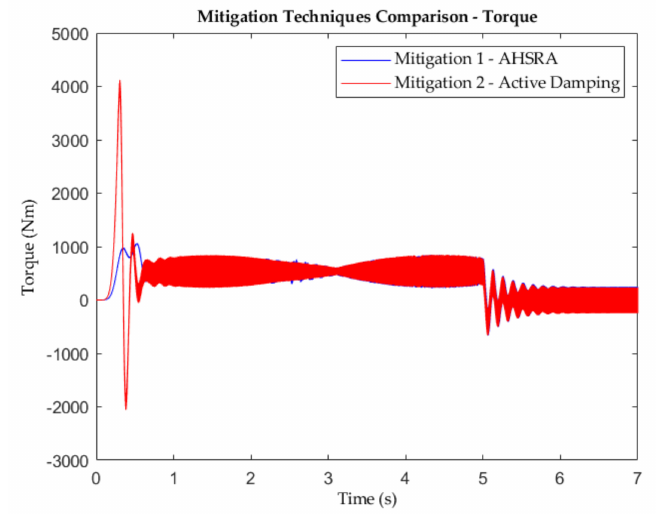
Figure 19. Mechanical torque—AHSRA (blue) vs. active damping technique